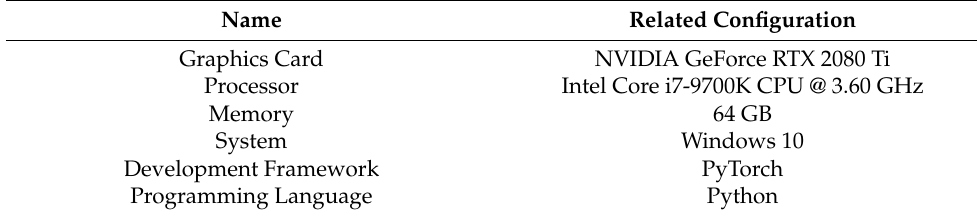
Table 2. Experimental